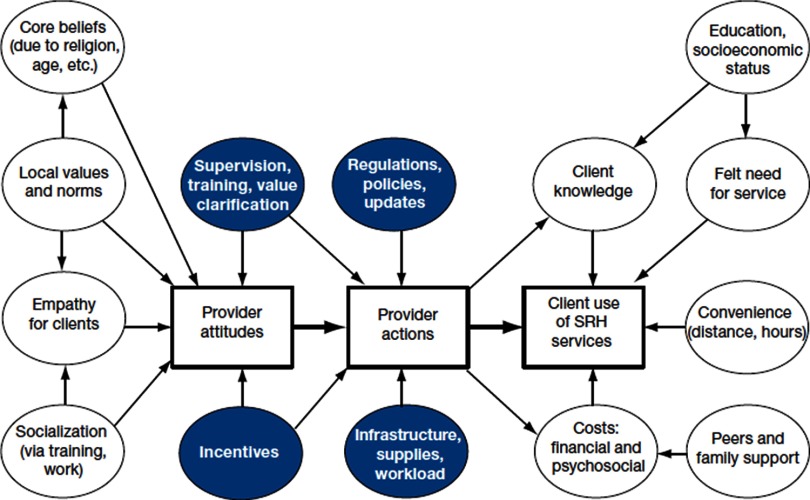
Conceptual Framework of Providers' Influence on Client Utilization of SRH ServicesAbbreviation: SRH, sexual and reproductive health.